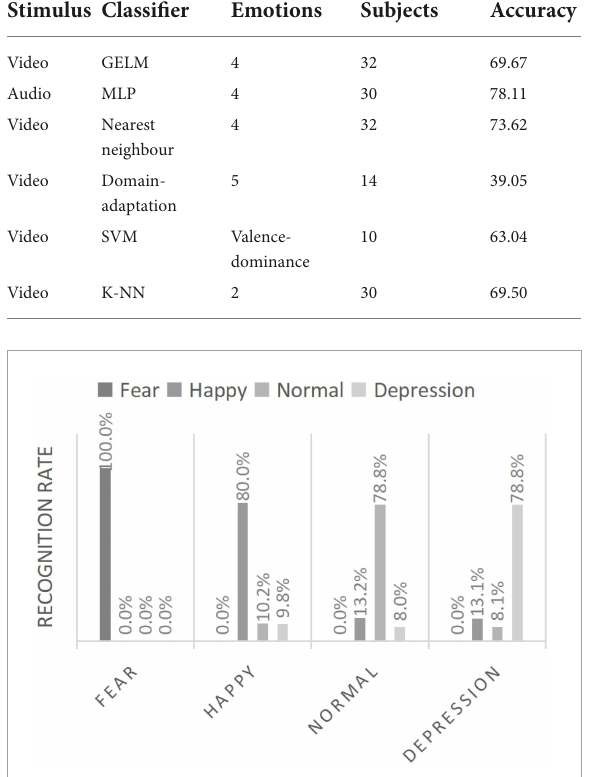
FIGURE2 Speech emotion recognition rate.